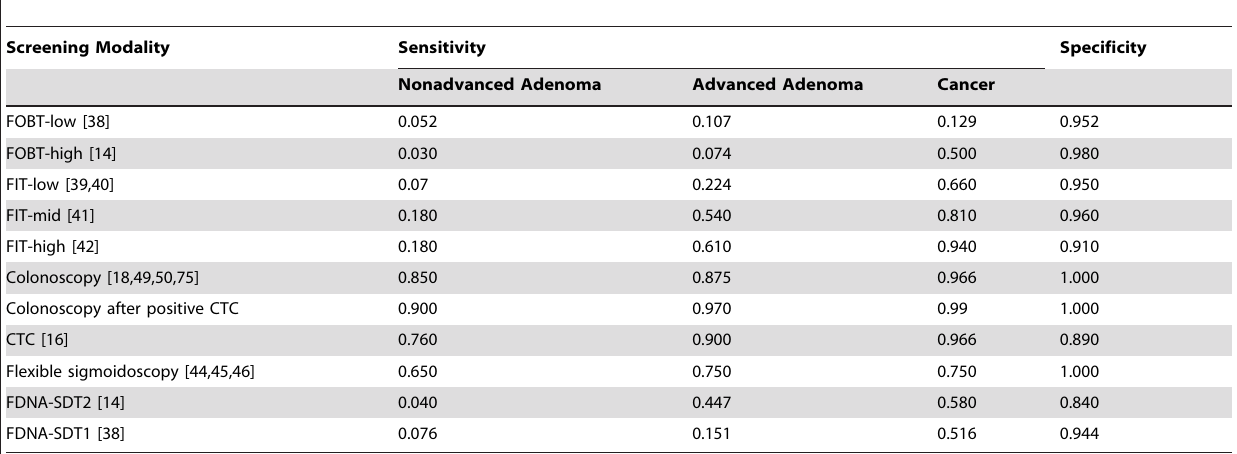
Table 2. Base case test performance characteristics for the screening